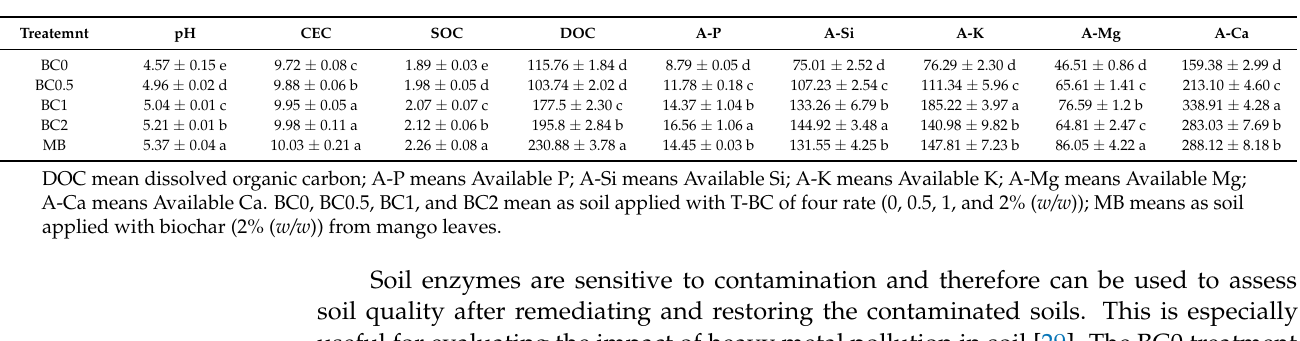
Table 2. The physical and chemical properties of the different treatments